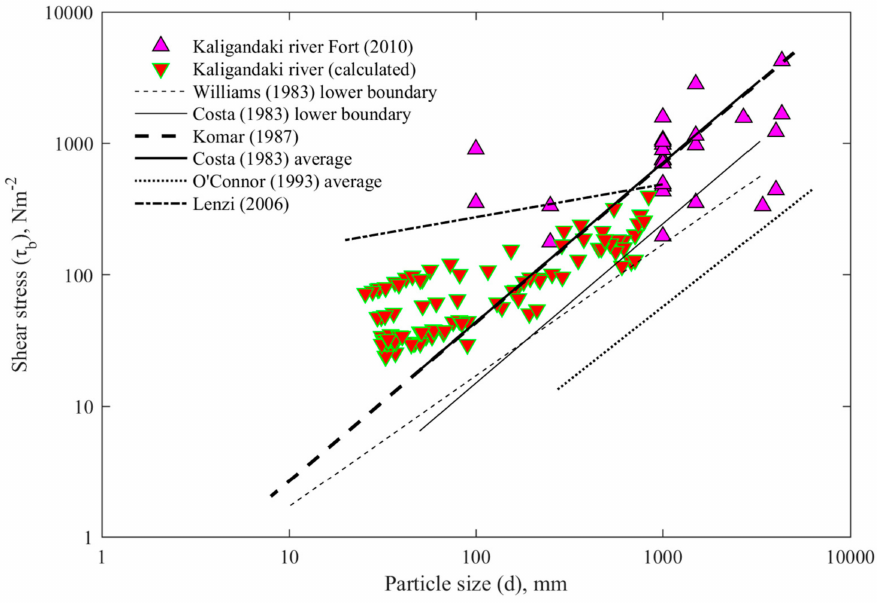
Figure 5. Relationship of shear stress and particle size (boulder) and a comparison with di ff erent